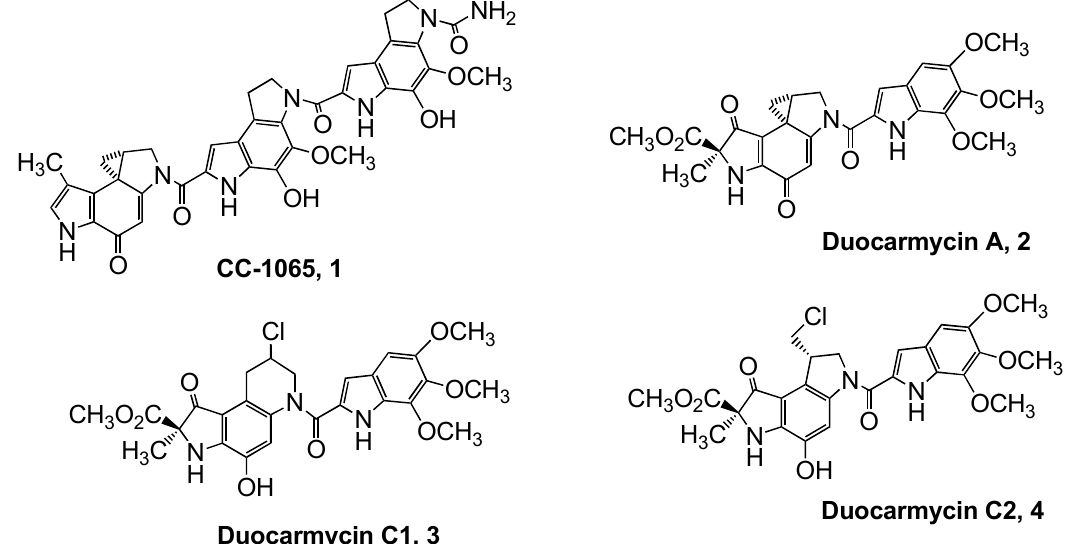
Figure 1. Structures of CC-1065 ( 1 ) and the duocarmycins, such as duocarmycin SA ( 2 ), duocarmycin C1 ( 3 ) and duocarmycin C2 ( 4